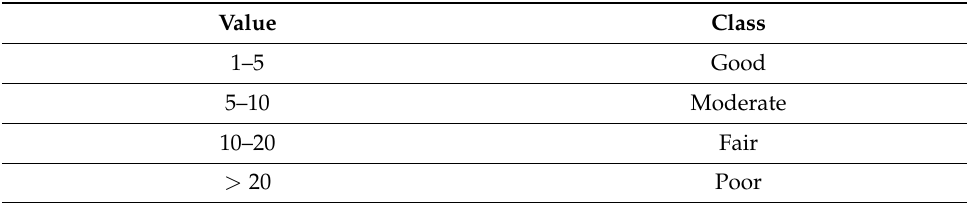
Table 3. Reference values for DOP